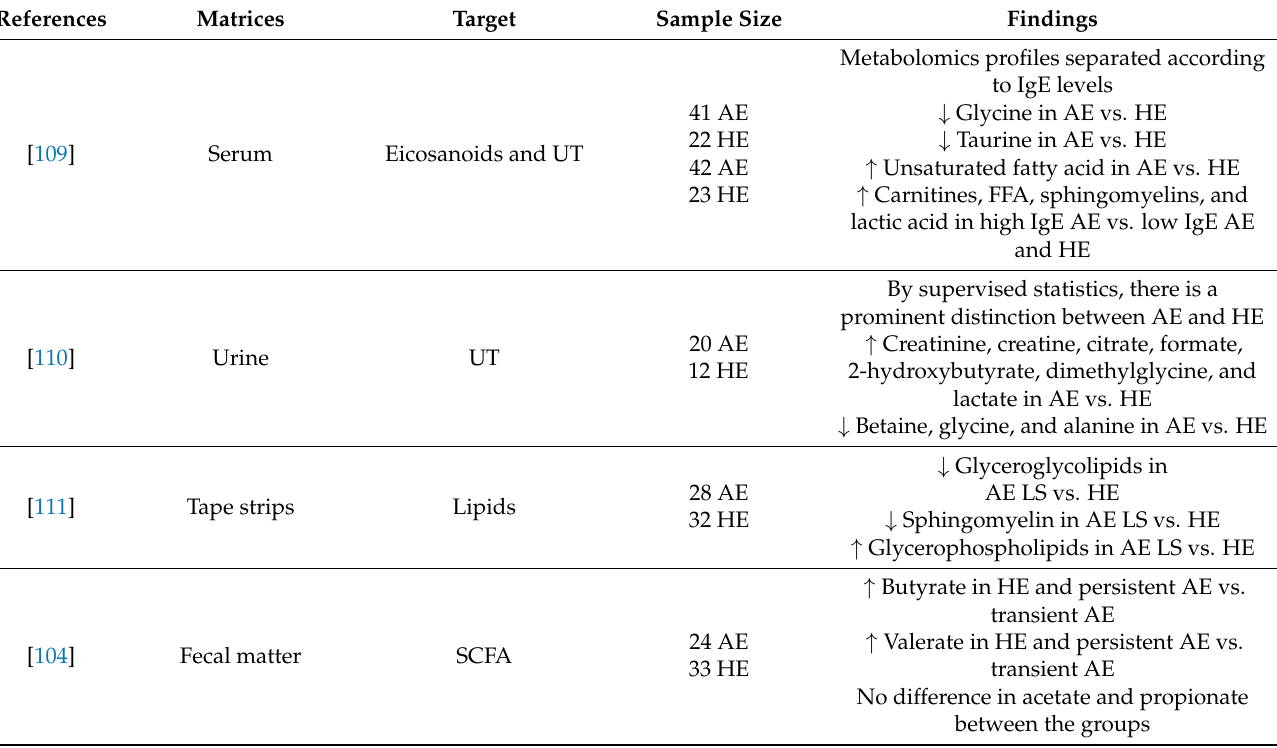
Table 4. Summary of AE metabolomics studies with infant samples. Abbreviations: AE (atopic eczema participants), LS (lesional skin), NL (non-lesional skin), HE (healthy participants), P (psoriasis participants), SCSFAs (short-chain saturated fatty acids), LCSFAs (long-chain saturated fatty acids), FA (fatty acids), ADMA (asymmetric dimethyl-arginine), C (chain length). Co. (cooperation), FLG (filaggrin), FFA (free fatty acids), UT (untargeted), IV (ichthyosis vulgaris), PBMCs (peripheral blood mononuclear cell), PUFA (poly-unsaturated fatty acids), and PCA (principal component analysis). Symbols: ↑ (increase) and ↓